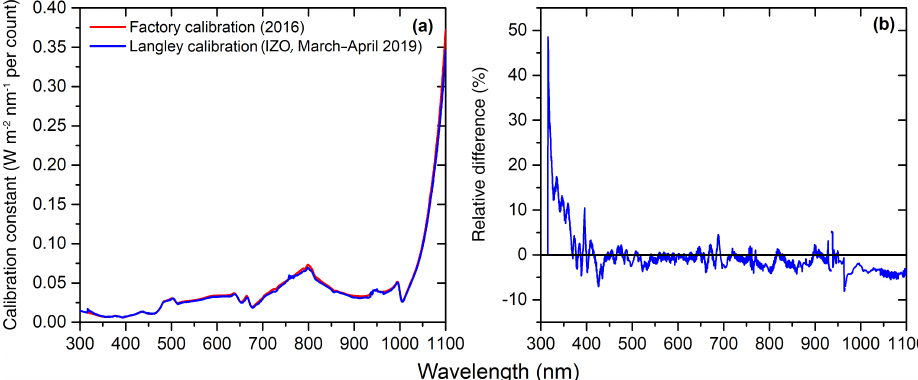
Figure 8. (a) Calibration constants (Wm − 2 nm − 1 per count) of the EKO MS-711 spectroradiometer, and (b) relative differences between factory calibration constants and those obtained from Langley plots at